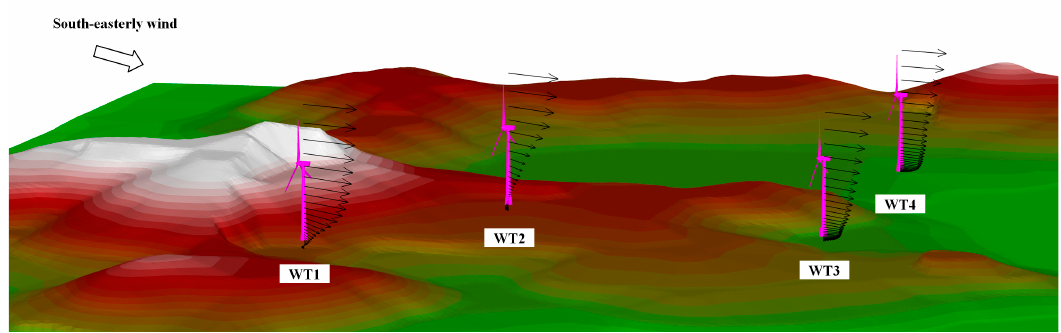
Figure 9. Wind velocity vectors at the wind turbine locations, time-averaged field. The averaging time period is 100 to 200 in non-dimensional time (see Figure 10).